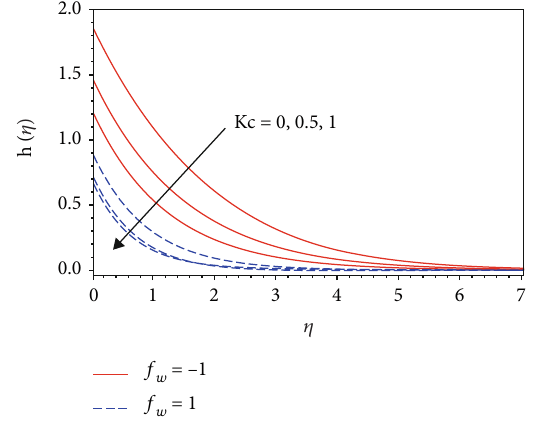
Figure 11: Concentration pro fi le for various values of Kc when Rc = 0 : 5, E = 0 : 1, M = 2, Sc = 0 : 6 and K 1